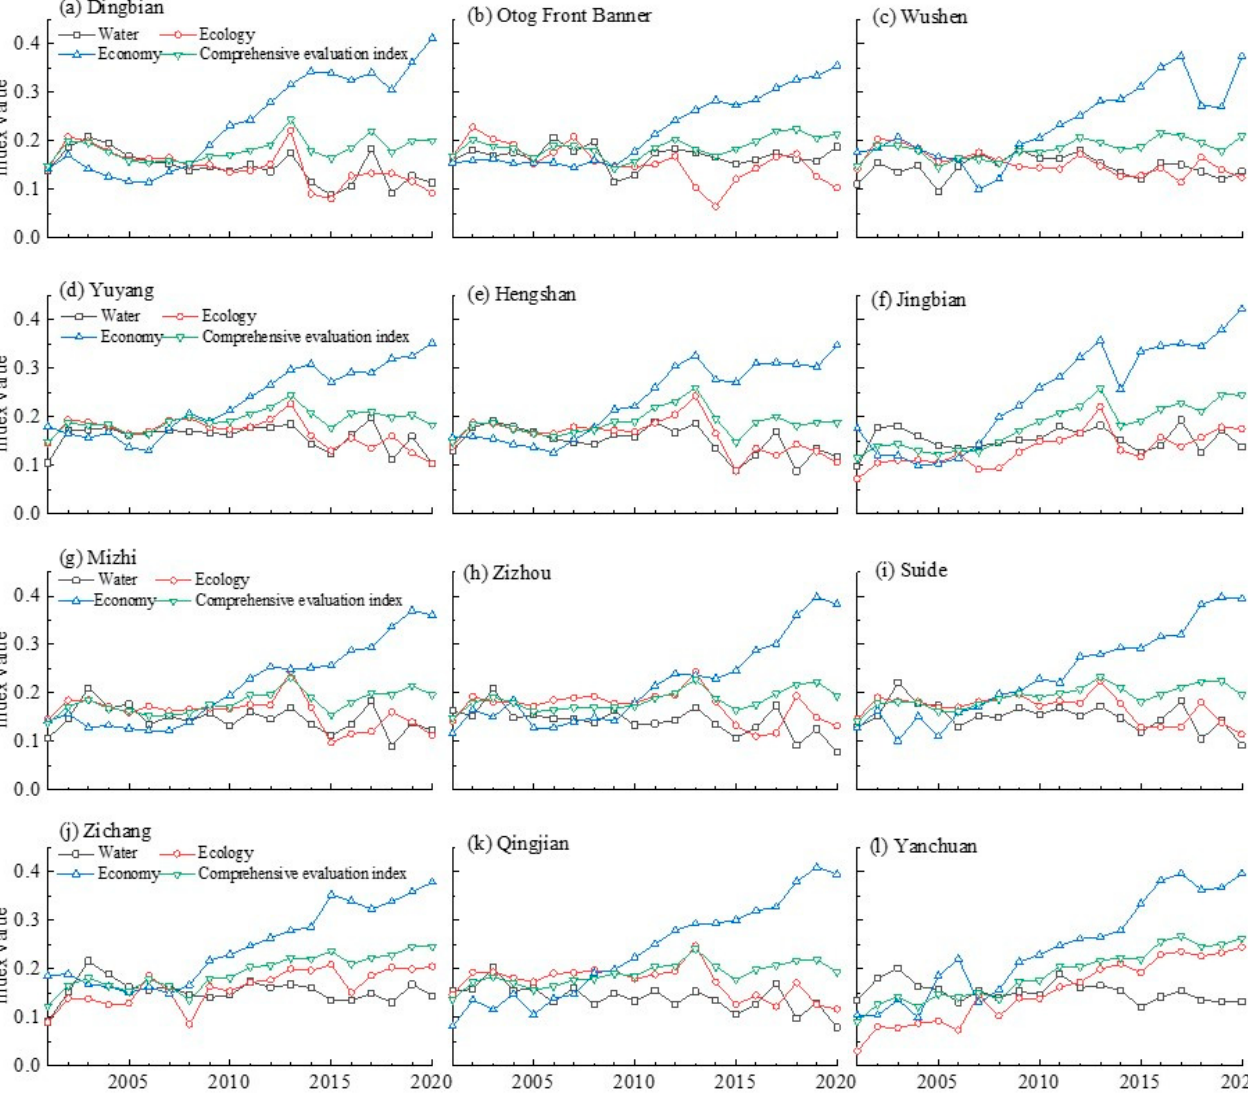
Figure 3. Interannual change trends in water, ecology and economy subsystem evaluation indices and their comprehensive index, respectively, in ( a – l ) in the Wuding River watershed from 2001 to 2020.